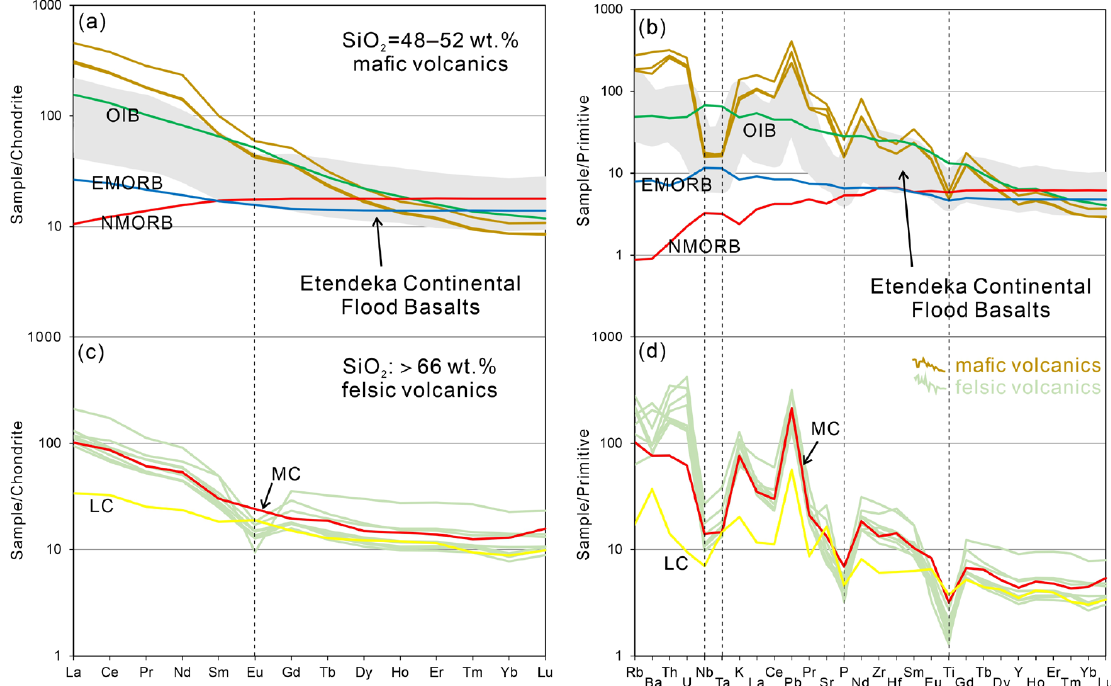
Figure 9. ( a , c ) Chondrite-normalized REE patterns; ( b , d ) Primitive-mantle normalized trace element spider diagrams for the Maoniushan Formation volcanics, eastern of the NQ. The chondrite data and the primitive mantle data for normalization are taken from Sun and McDonough [92]. The Low/Middle Crust (LC/MC) data are taken from Rudnick and Gao [93]. Oceanic island basalt (OIB), Enriched mid-ocean-ridge basalt (EMORB), and Normal mid-ocean-ridge basalt (NMORB) data are from Sun and McDonough [92]. Etendeka continental flood basalt data are from Ewart et al. [94,95]. On the primitive mantle-normalized trace element spider diagram (Figure 9b), the samples exhibit relative enrichments in large ion lithophile elements (LILEs; Rb, Th, and K) and depletions in high-field-strength elements (HFSEs; Nb, Ta, P, and Ti), which are similar to the continental flood basalt contaminated by the crust at Etendeka, Namibia [94,95], indicating that these may be related to asthenospheric mantle upwelling (plume) and continental